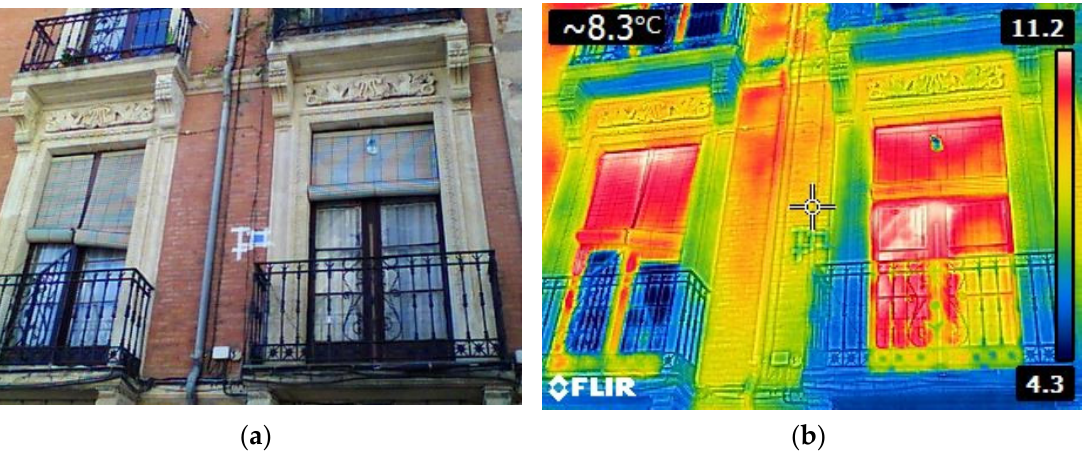
Figure 1. ( a ) Placement of the thermal flow plate and probes on the exterior face of the facade; ( b ) Thermographic image of the facade.